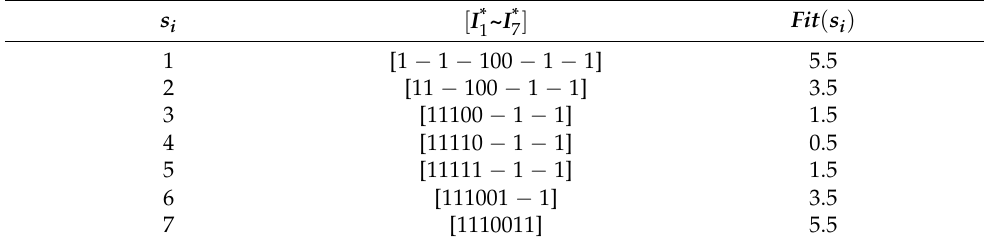
Table 3. Solution results of fitness value of each